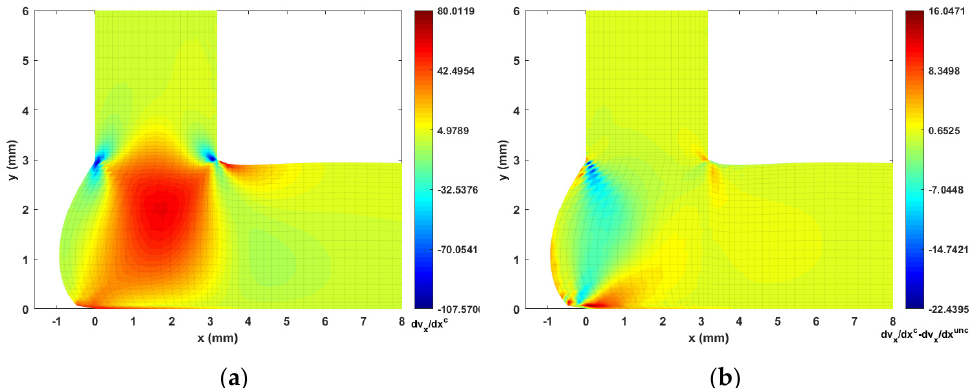
Figure 14. Velocity gradient contour dv x / dx near extrusion-deposition transition region: ( a ) fully coupled solution; ( b ) difference between the fully coupled and uncoupled solutions.